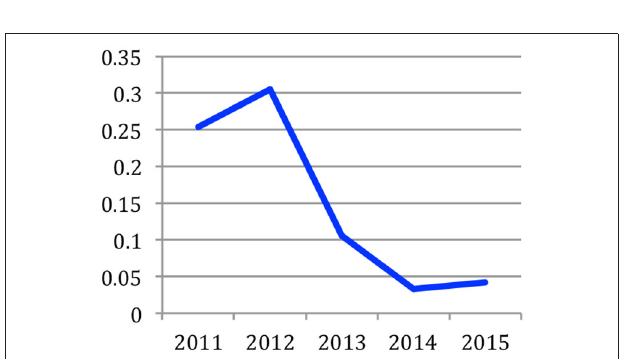
FIGURE 8 | Reliability of the predictions: prediction error over the years from 2011.